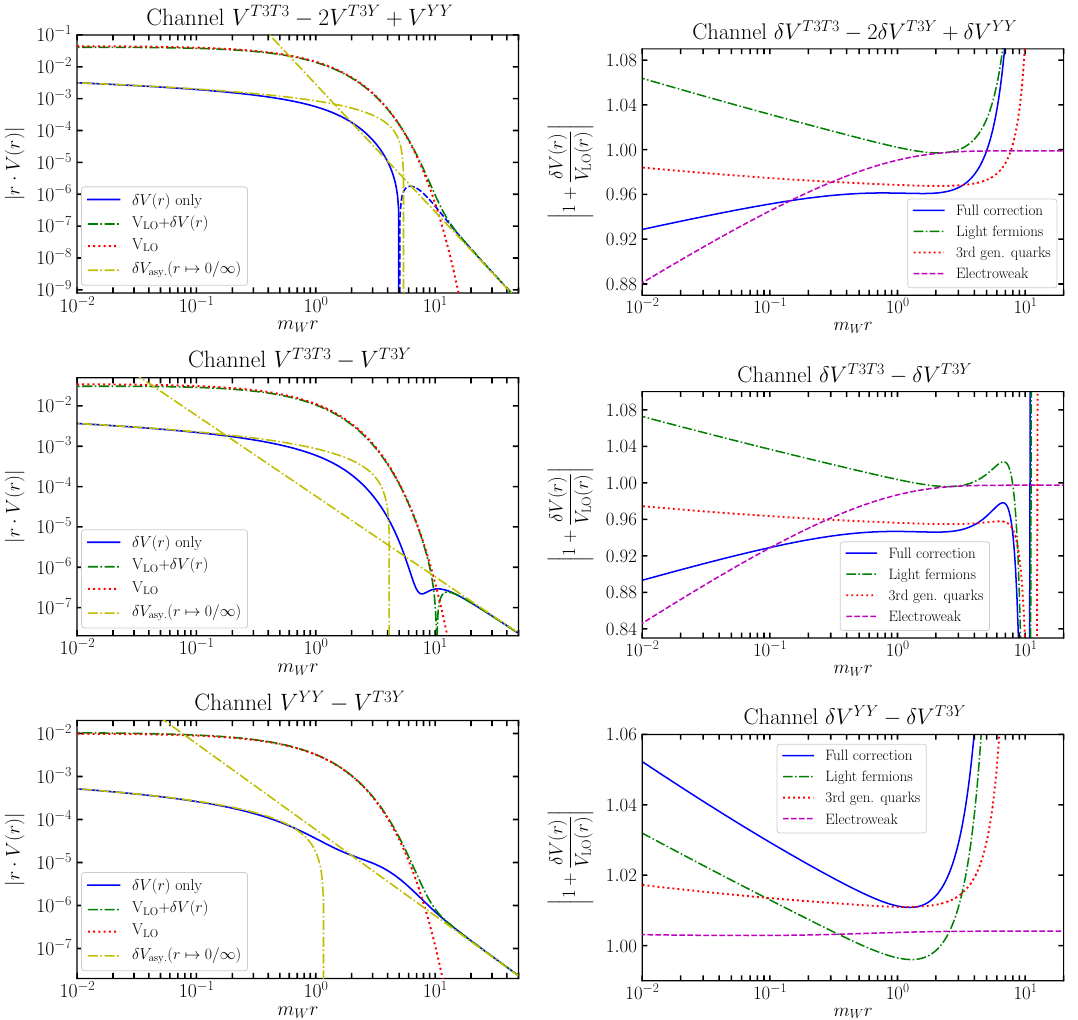
Figure 5 . The NLO correction to the tree-level Z -boson only exchange potentials discussed in the text. The left panel shows the modulus of the potential | r · V ( r ) | for the LO and NLO potential, the NLO contribution only, and the large-distance asymptotic behaviour (the change from solid to dashed for the correction only line, indicates the sign change of this term). In the right panel, we show the ratio of the full NLO potential to the LO potential (blue solid) and separately for the three gauge invariant pieces identified in the text (other curves). The upper plots correspond to the linear combination given in (4.18), the middle and lower plots to the linear combinations in